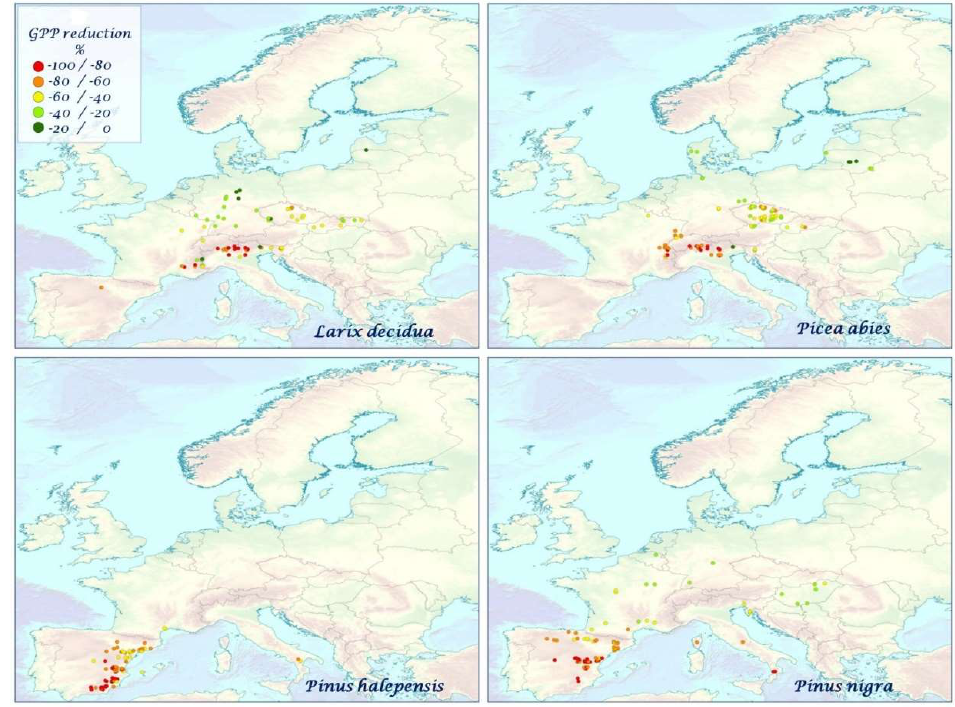
Figure 7. The mean species–specific GPP reduction (%) for L. decidua, P. abies, P. halepensis, P. nigra over the time period 2000–2010.